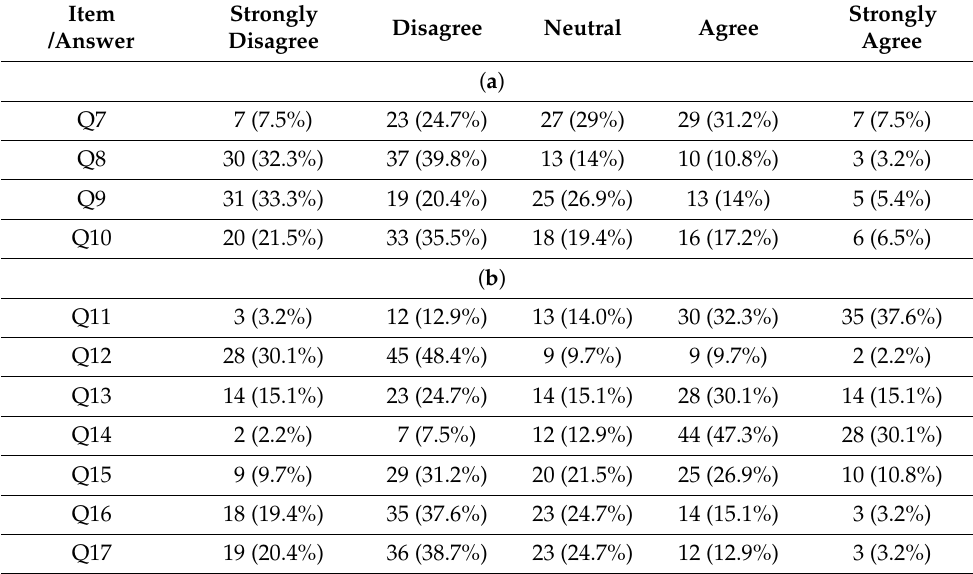
Table 2. ( a ) Distribution of the university teachers according to the answers from the survey, on the psychological impact. ( b ) Distribution of the university teachers according to the answers from the survey, on the educational